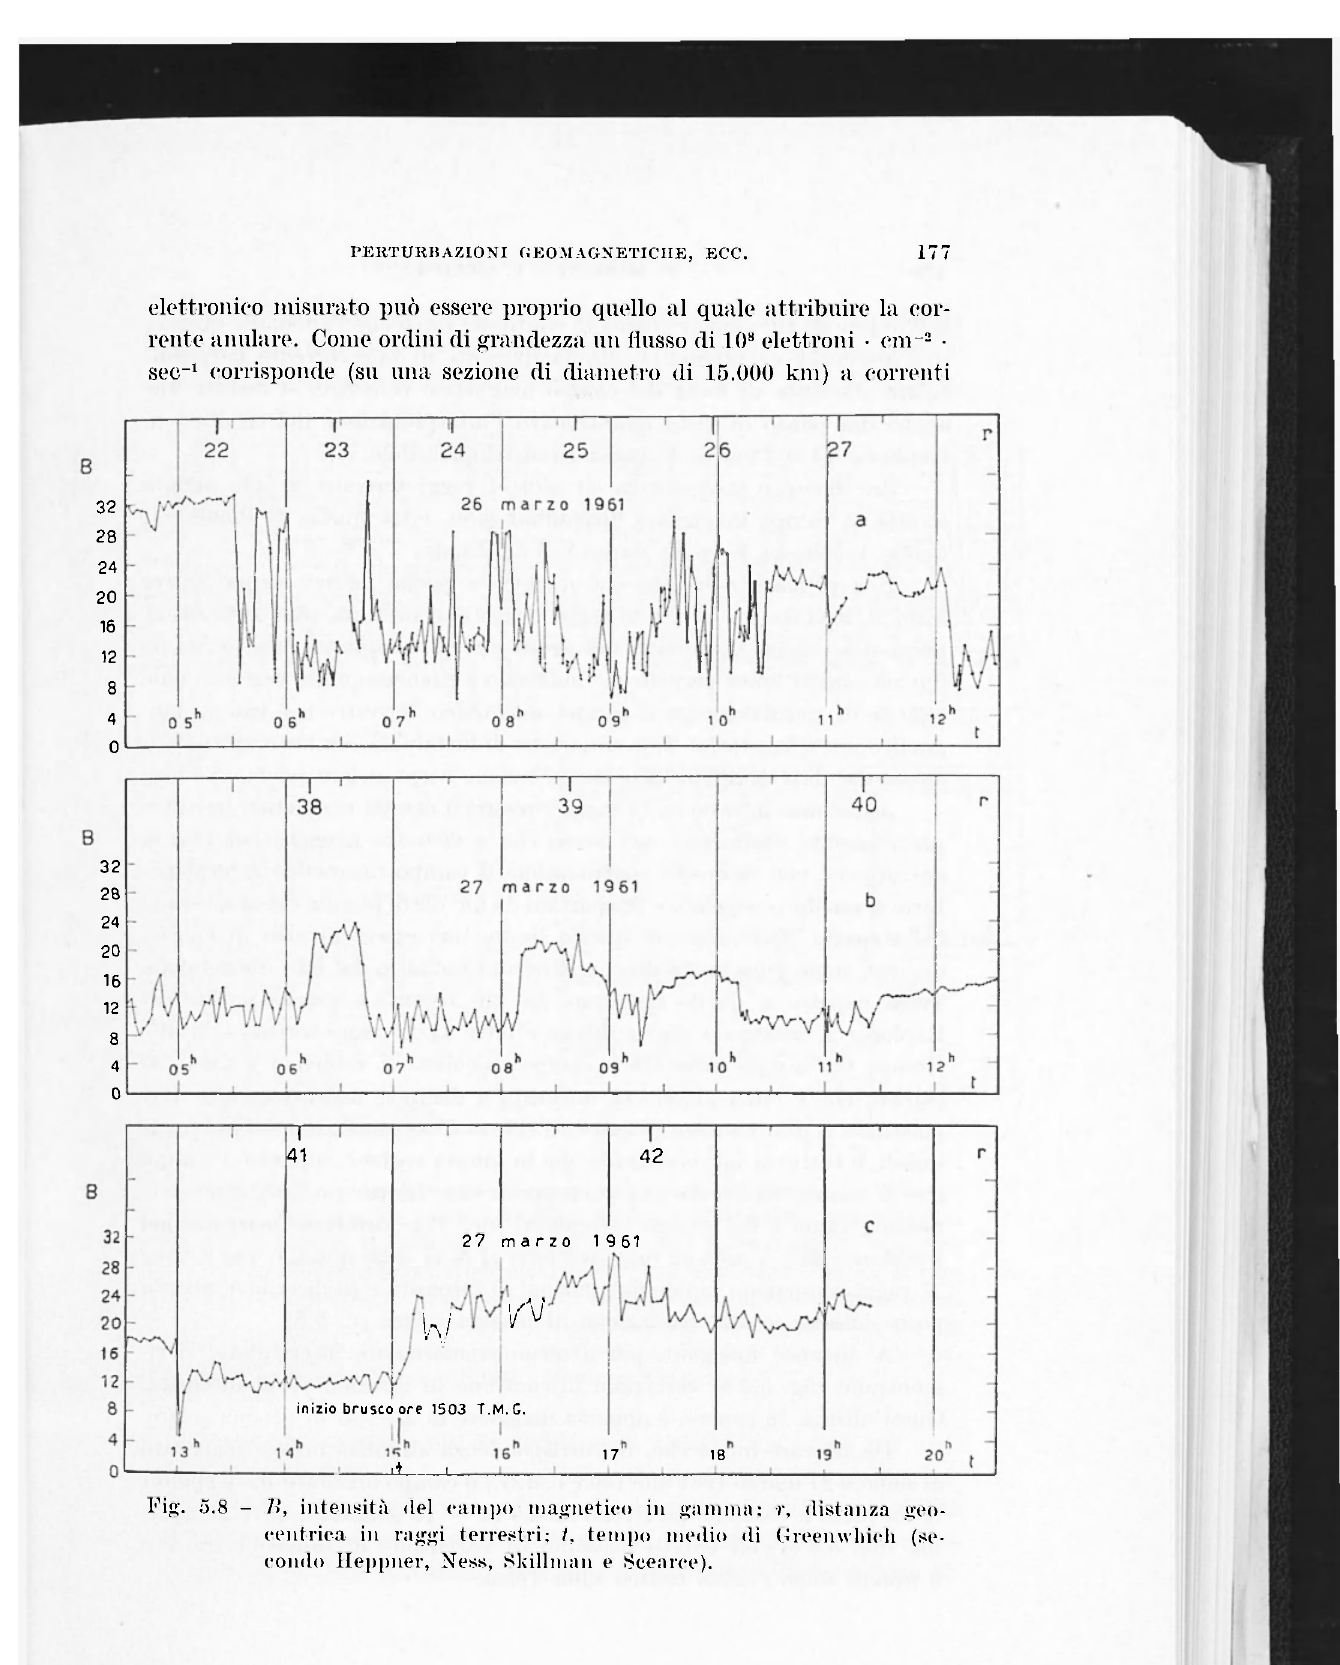
Fig. 5.8 - B, intensità del campo magnetico in gamma; r, distanza geo- centrica in raggi terrestri; t, tempo medio di Greenwliich (se- condo Heppner, Ness, Skillman e